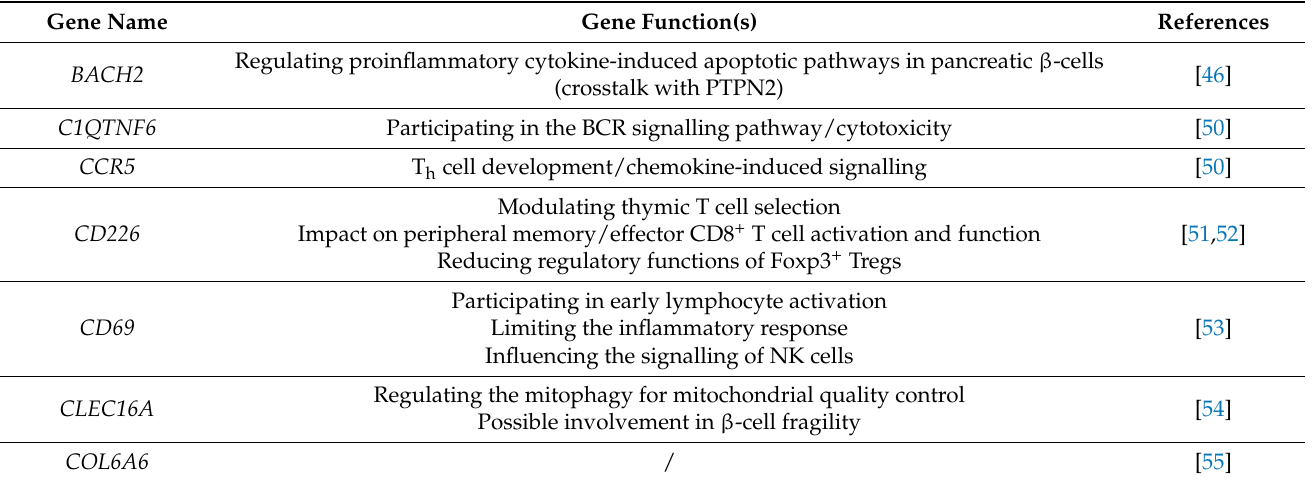
Table 1. Genes connected to T1D pathology and their influence on β -cell and/or immune cell functions.